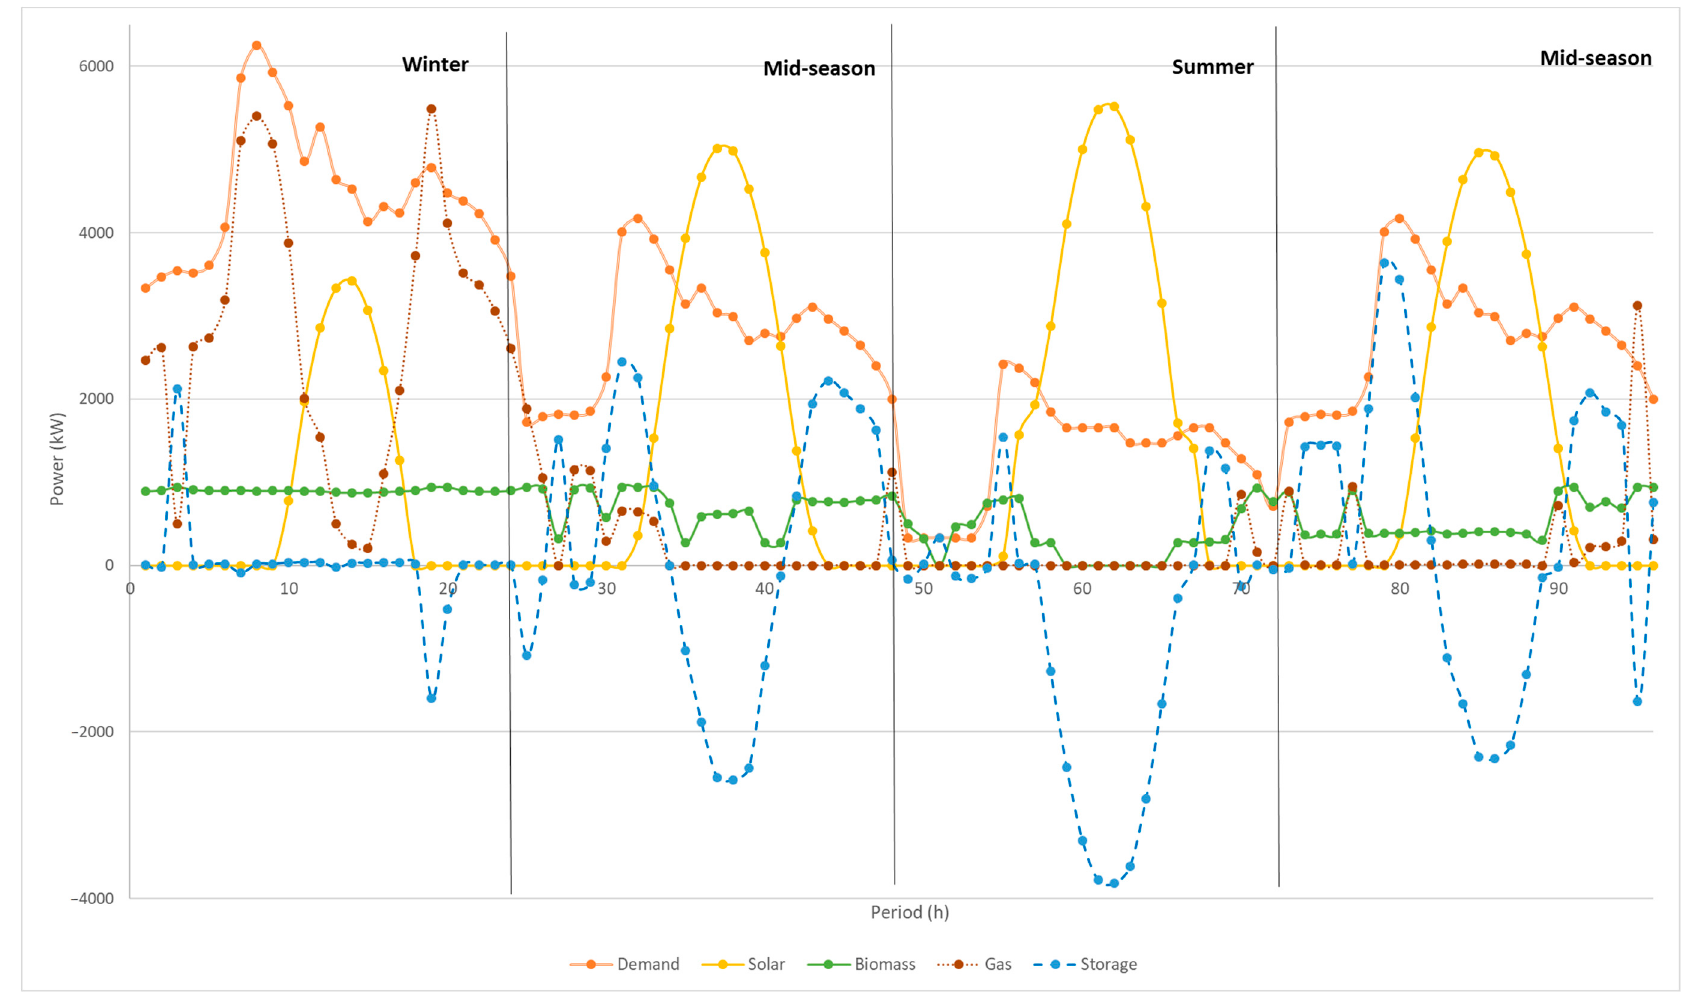
Figure 11. Optimal power operation for model presented in methodology for approach b.